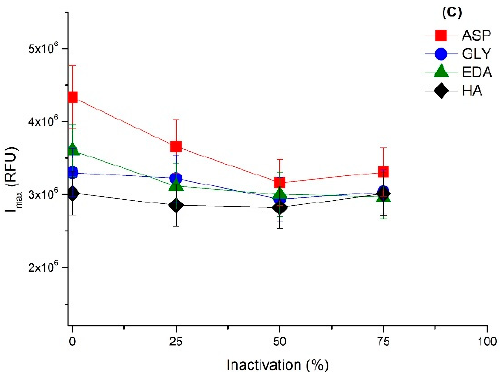
Figure 10. Changes of the intrinsic fluorescence (Imax at λ max) during the different biocatalysts inactivation. Imax at λ max was plotted for the different CALB at different inactivation degrees. The inactivation percentage is the activity lost by the different CALB biocatalysts after being incubated at a certain time at different pH under inactivating temperatures. Conditions: ( A ) pH 5; ( B ) pH 7; and ( C ) pH 9. RFU = relative fluorescence units.